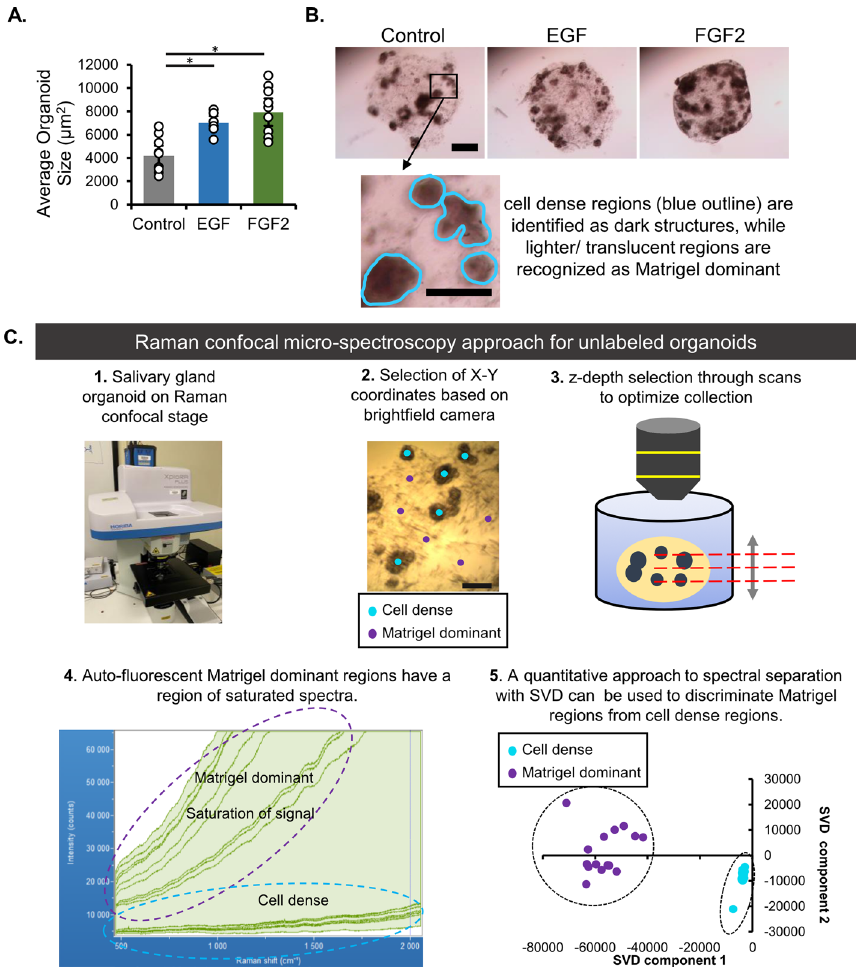
Fig. 2 Development of Raman confocal microspectroscopy method to evaluate salivary gland organoids. A Quantification of organoid size based on area. n 7 technical replicates across three experiments = (statistical summary in Additional file 1: Table S4). B Representative images of control and growth factor-treated organoids prior to Raman imaging, with the cell-dense, largely epithelial regions highlighted in zoomed panel. Scale bar, 500 µm (panel), 250 µm (zoomed region). C Visualization of the Raman confocal microspectroscopy method for identification of cell-dense regions. This method allows the separation of cell dense-organoid regions from Matrigel-dominant, or stromal, regions, which can be done either manually by peak comparison or with a multivariate SVD